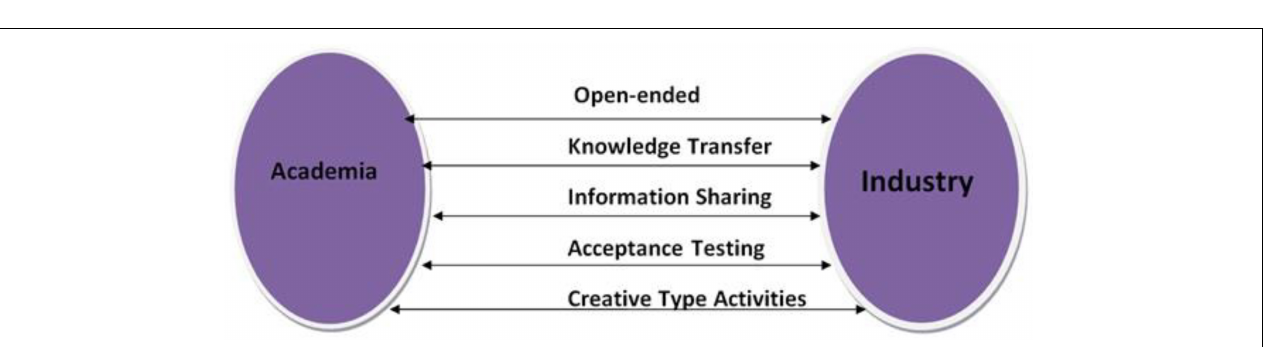
Frontiers in Psychology |